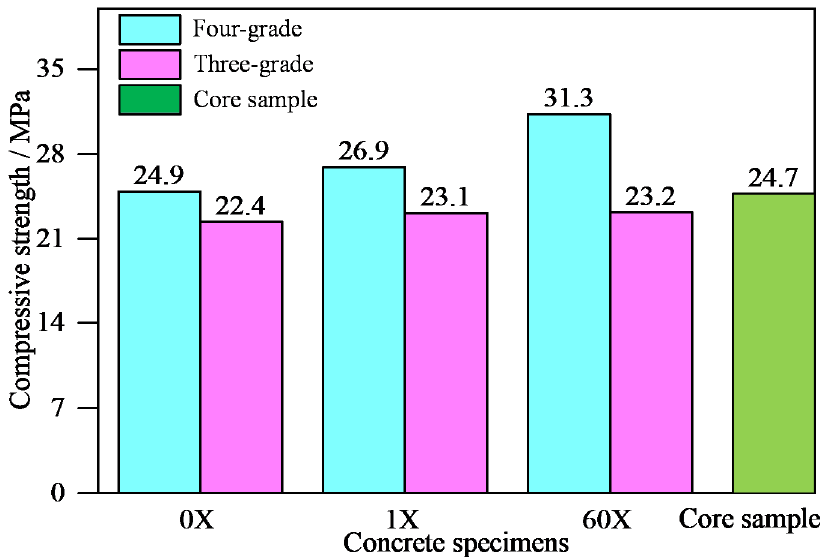
Figure 12. Comparison of compressive strength between four-grade concrete, three-grade concrete and core samples from the WDD